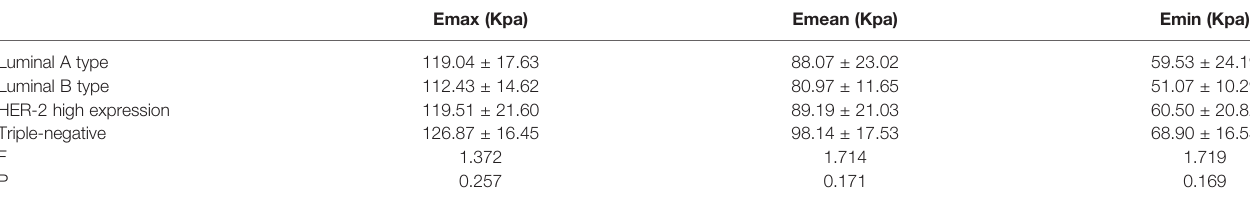
TABLE 4 | Variance analysis of SWE elastic modulus and different molecular subtypes of breast